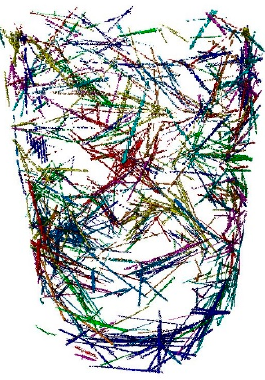
Figure 7. 3D view of the fibers belonging to steel fiber-reinforced concrete.